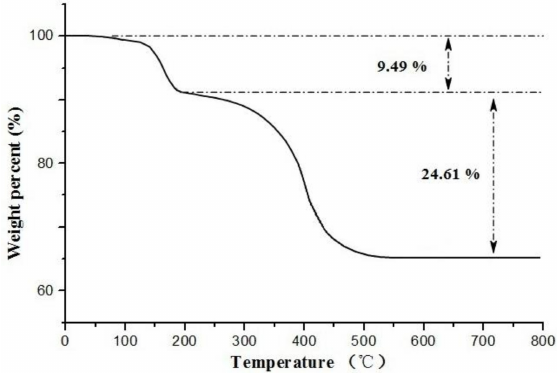
Figure 6. Thermo gravimetric analysis (TGA) curve of ECB-MICMs.